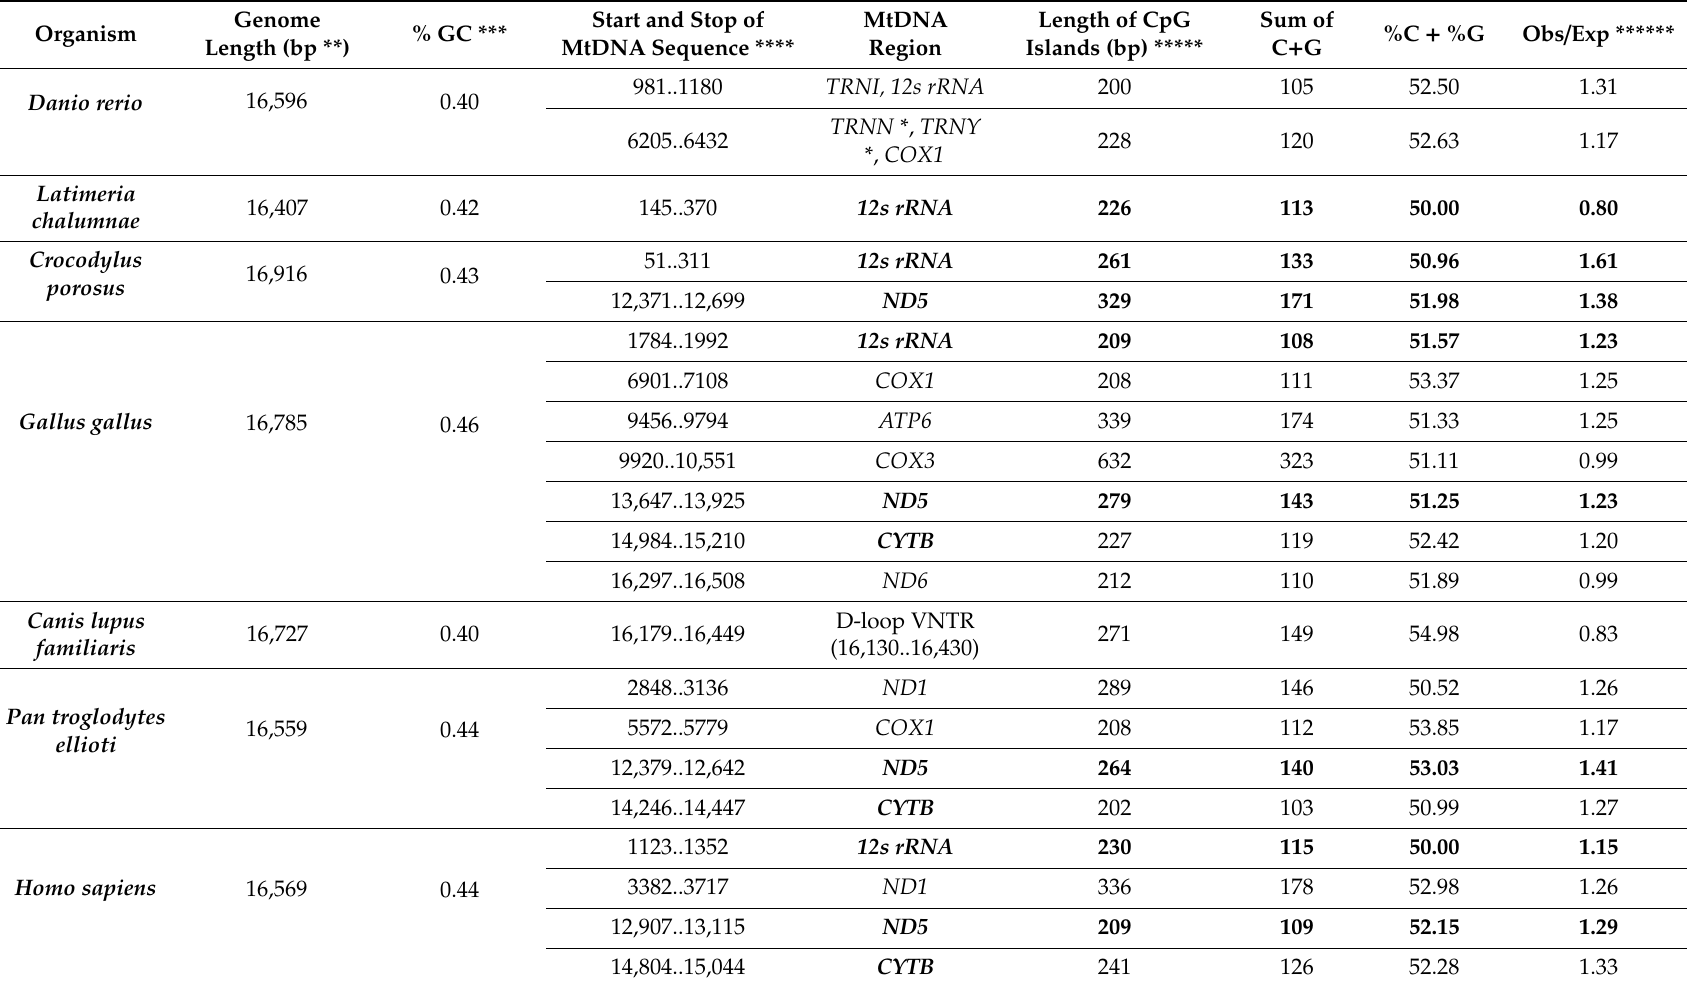
Table 3. Positions of CpG islands in the mtDNA of the analysed animals on the H strand